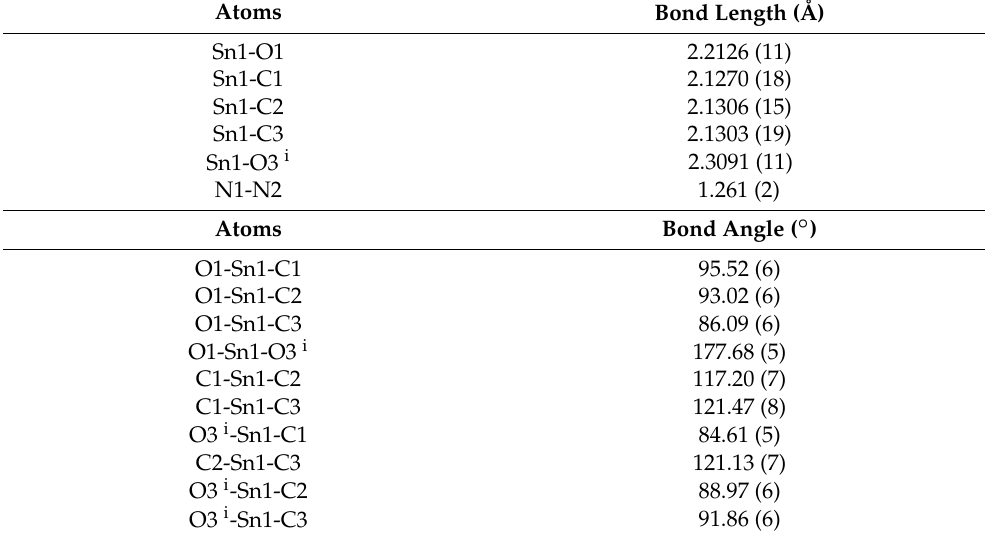
Table 2. The selected bond lengths (Å) and bond angles ( ◦ ) for 1